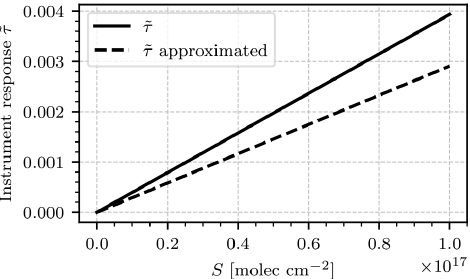
Figure A1. Comparison of the true instrument signal ˜ τ , as ob- tained in Sect. 2.1 (solid line), and the analytical approximation in Eq. (A6) (dotted line). The column density in the gas cell is S c = 4 · 10 18 molec.cm − 2